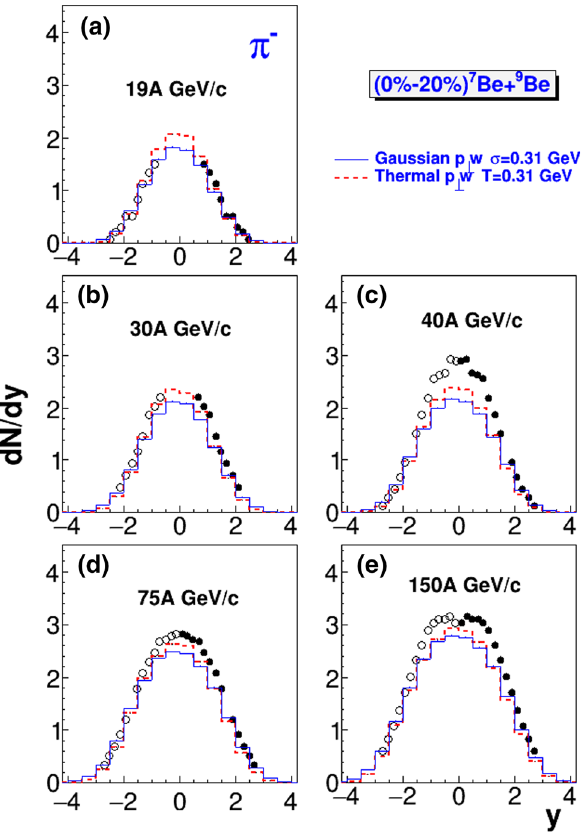
Fig. 6 Rapidity distributions of negative pions in the 20% most cen- tral 7 Be + 9 Be collisions. Predictions of the PYTHIA 8.303/Angantyr calculations using Gaussian and thermal models are shown in thin and short-dashed lines, respectively. The data have been symmetrized. The closed points represent NA61/SHINE [10] data and open points are symmetrized